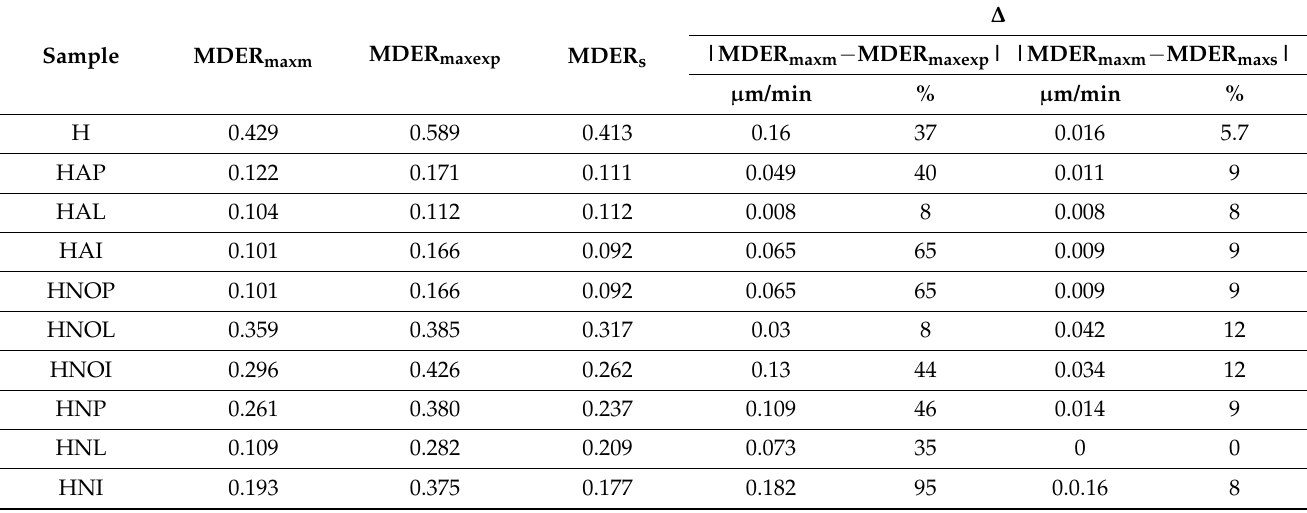
Figure 13. Appearance of macrostructural surfaces (left front section, parallel to the eroded surface, right in cross section, background optical microscope image, detailed stereomicroscope image) subjected to 5083 alloy cavitation erosion, cast followed by solution hardening 450 ◦ C/maintenance 100 min/cooling quiet air and subjected to artificial aging at 140 ◦ C and different maintenance times: ( a ) 1 h; ( b ) 12 h; ( c ) 24 h. Table 5. Parameters of erosion–cavitation process of the experimental 5083 aluminum